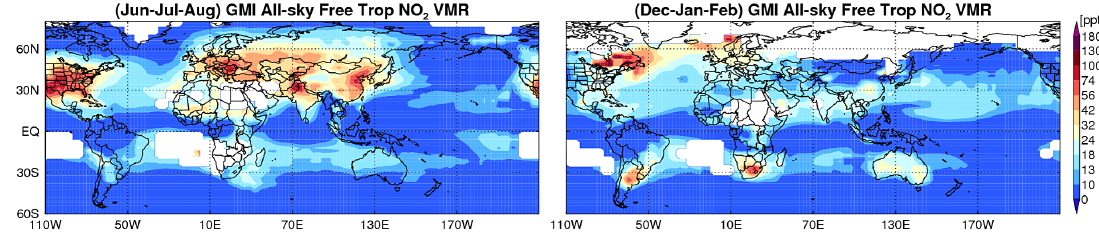
Figure C2. GMI all-sky free-tropospheric NO 2 for June–August (left) and December–February (right) averages over 2005–2007.